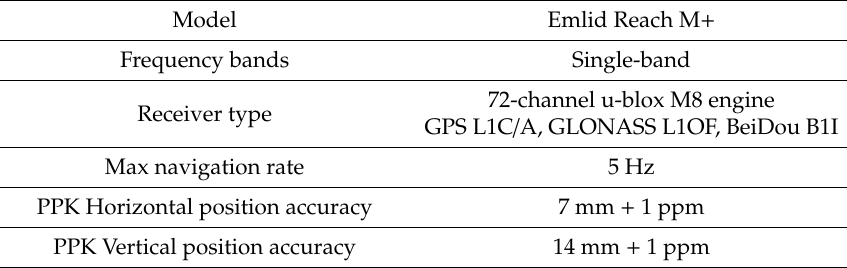
Table 3. Camera parameters.